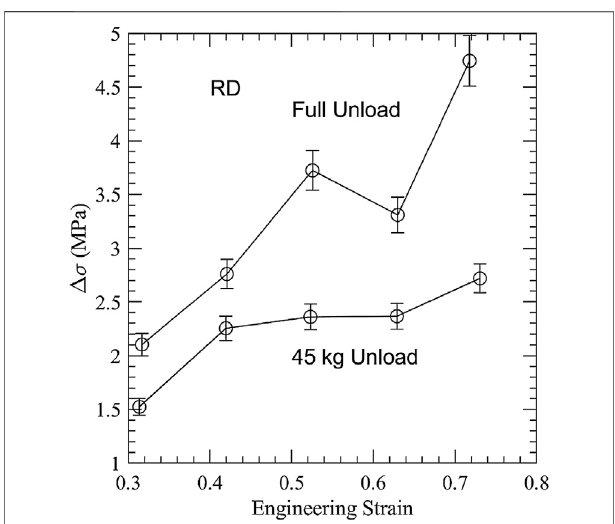
FIGURE6| Changeinyieldingofa304stainlesssteelduringinterrupted tensile testing performed at room temperature and a strain rate of 0.001 s − 1 , with a full unload and partial unload between straining steps without an isothermal hold at room temperature.